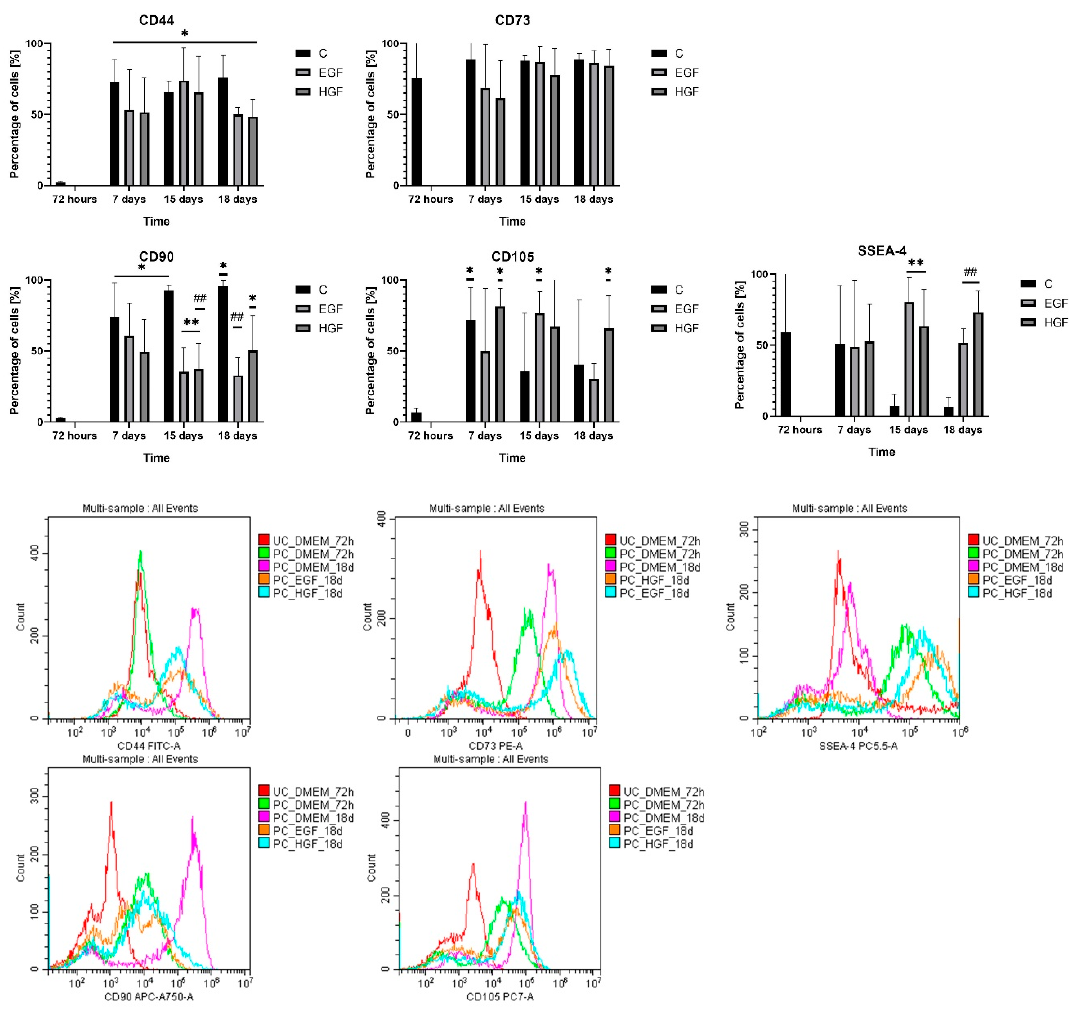
Figure 3. Percentage of CD44+, CD73+, CD90+, CD105+, and SSEA-4+ in the control culture (C) and subjected to differentiation (EGF and HGF). Statistically significant differences ( p < 0.05) compared with group (C) at * = 72 h, ** = 15 days, and ## = 18 days; n = 3. The histograms present representative samples of fluorescence spectra in flow cytometry. UC—unstained cells; PC—stained cells. The primary hAEC population was characterised by low expression of CD44